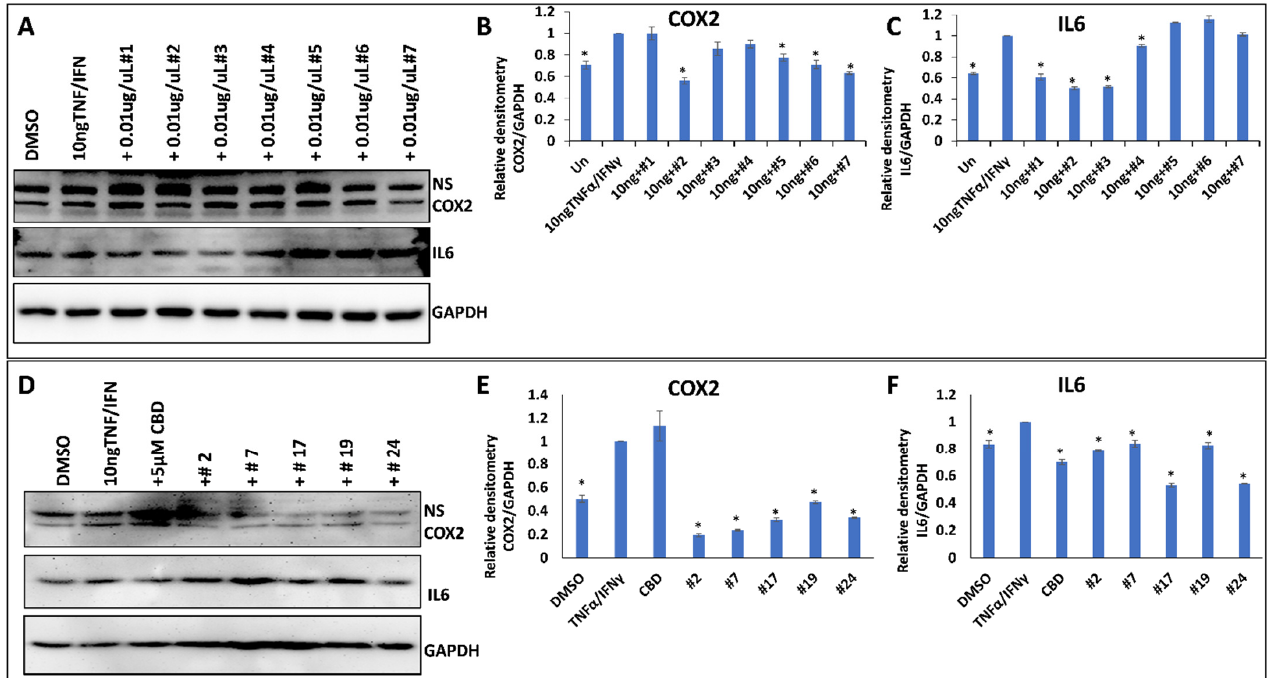
Figure 4. The effect of selected extracts on the expression of COX2 and IL6 in WI38 cells treated by 10 ng/mL TNF- α /IFN- γ . ( A )—Western blot image of COX2, IL6 and GAPDH in response to DMSO, 10 ng/mL TNF- α /IFN- γ , or TNF/IFN together with one of the extracts, from #1 to #7. ( B )—ImageJ calculated the densitometry of COX2 for samples #1–#7. ( C )—ImageJ calculated the densitometry of IL-6 for samples #1–#7. ( D )—Western blot image of COX2, IL6 and GAPDH in response to DMSO, 10 ng/mL TNF- α /IFN- γ , 10 ng/mL TNF- α /IFN- γ plus 5 µM CBD, or TNF/IFN together with one of the extracts— #2, #7, #17, #19 and #24. ( E )—ImageJ calculated densitometry of COX2 for samples #2, #7, #17, #19 and #24. ( F )—ImageJ calculated densitometry of IL-6 for samples #2, #7, #17, #19 and #24. Data are shown as average relative to GAPDH, calcu- lated from 3 independent measurements, with SE. Asterisks show significant difference from TNF- α /IFN- γ treatment ( p < 0.05). NS—non-specific binding.